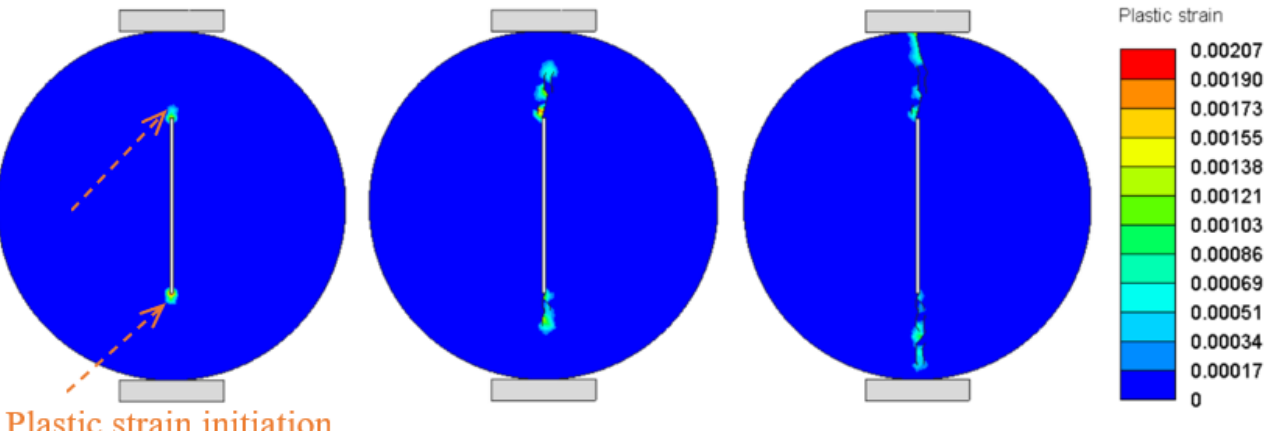
Figure 17. Plastic strain evolution for Brazilian disc with a crack of 0° angle.